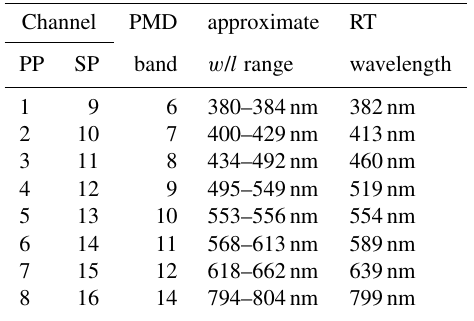
Table 2. Definition of MICRU PMD channels for PP and SP polarisation, respectively. PMD band definitions are compiled